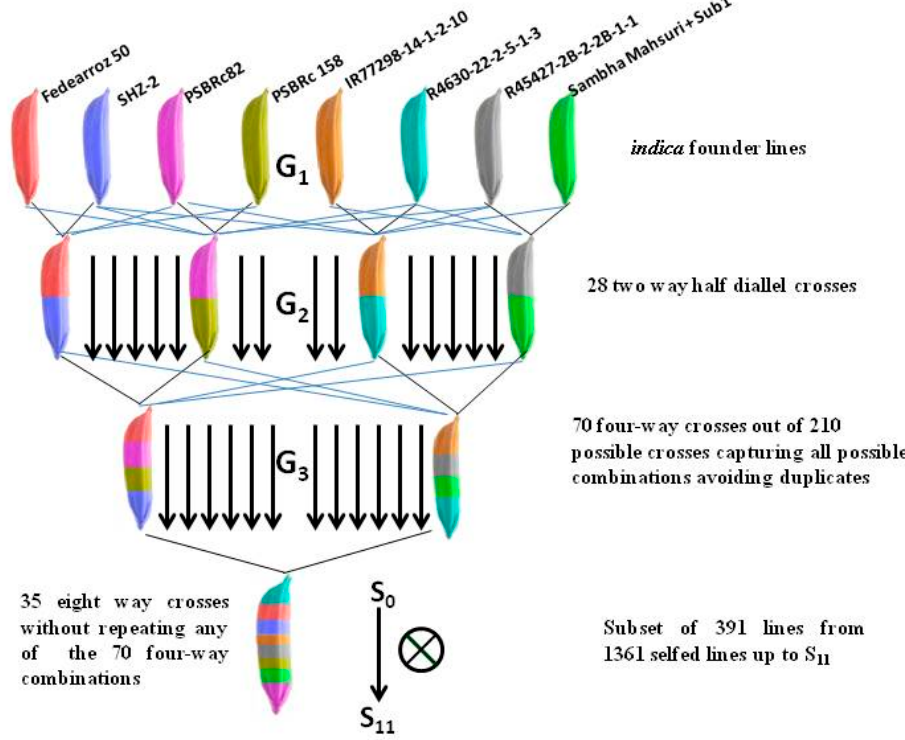
Figure 1. Development of the multi-parent advanced generation intercross indica (RiMi) population using eight indica founder lines.